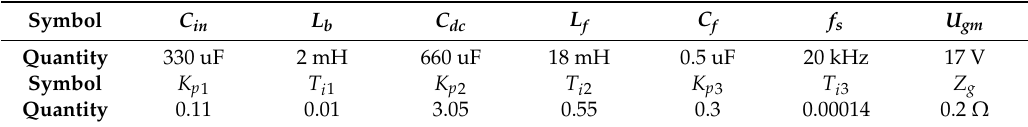
Table 5. Converter